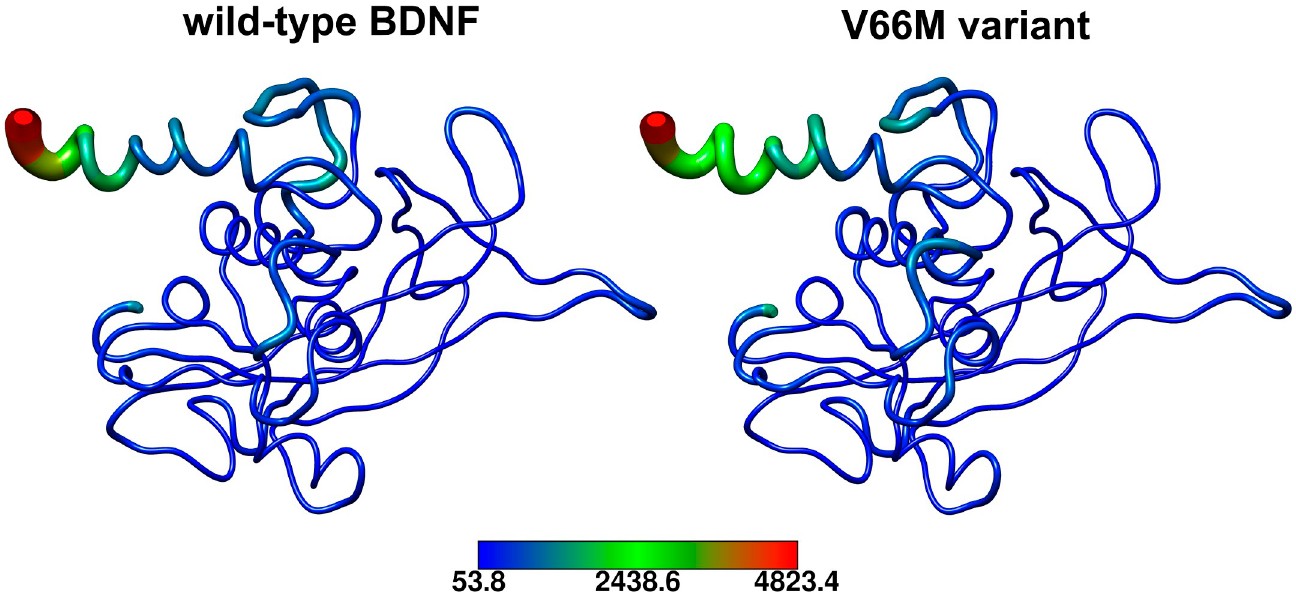
Fig 10. B-factor representation of wild-type BDNF and its V66M variant. The B-factor values of each residue of wild-type BDNF and its V66M variant expressed in a coloring-thickness scheme. Higher B-factor values are represented as red and bulky structures, while lower B-factor values are represented as dark blue and thin structures.